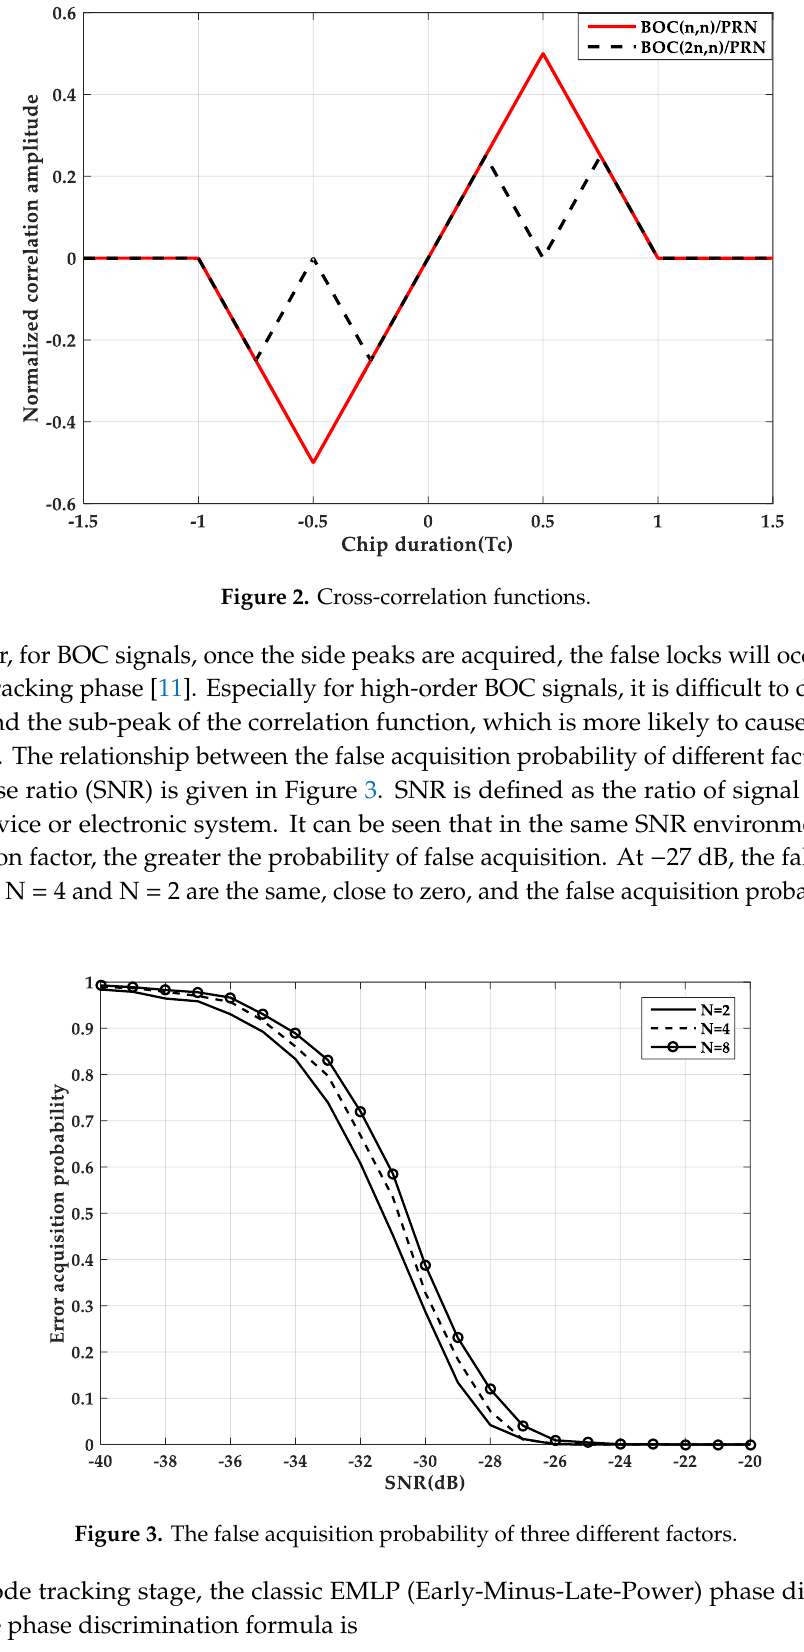
Figure 4. The discrimination curves for the three methods. 2.2. Generation of Sub-PRN Code Sequences By definition, the BOC code and the PRN code are expressed in the form of pulses as follows. (